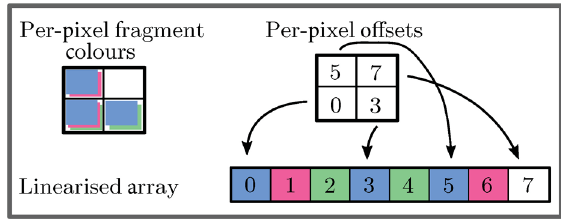
Fig. 3 Per-pixel blue/red/green, blue/green, and blue/red fragment colours as linearised